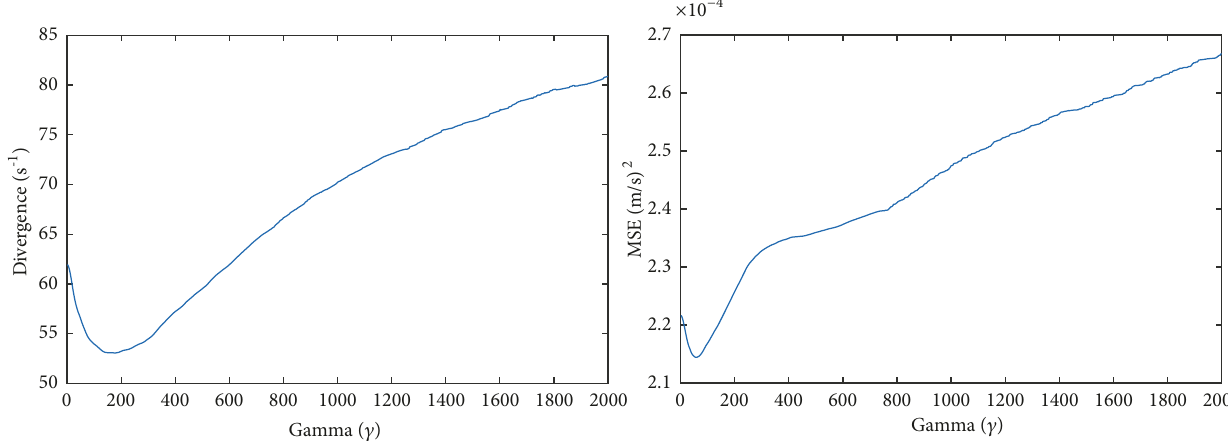
Figure 9: Divergence and MSE profiles of the proposed method as 𝛾 is increased linearly while 𝜆 = 1 .